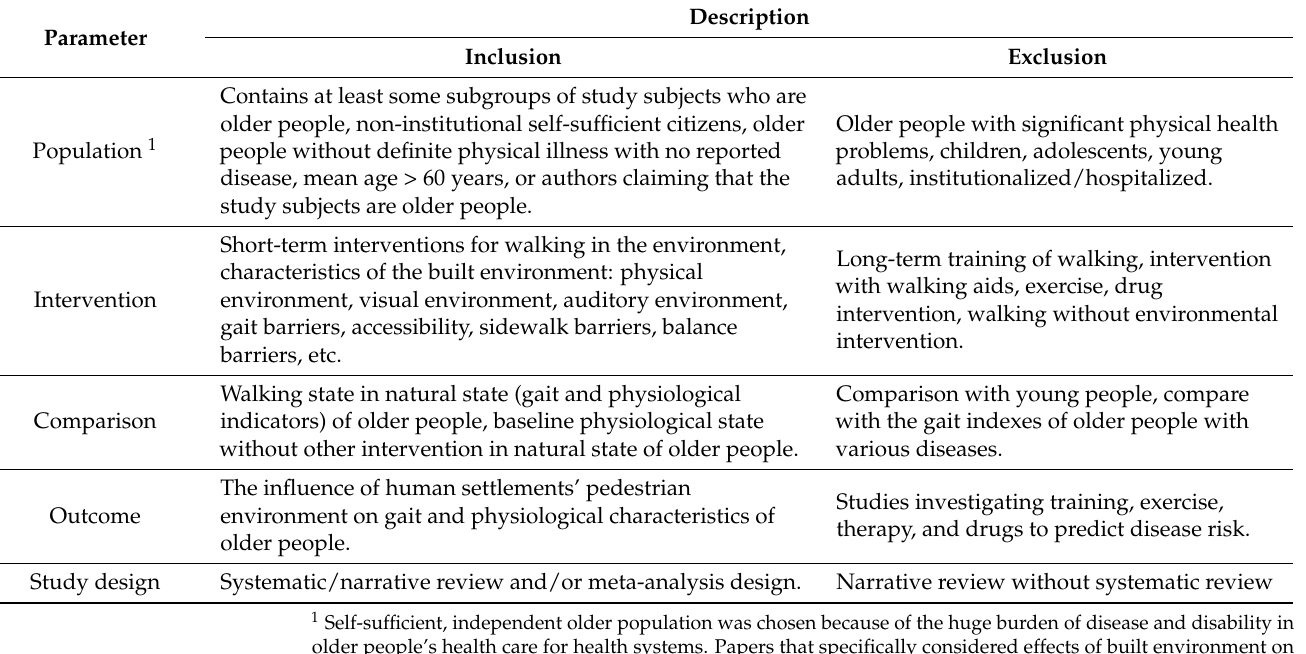
Table 1. PICOT (population, intervention, comparison, outcome, type of study) scheme to define inclusion